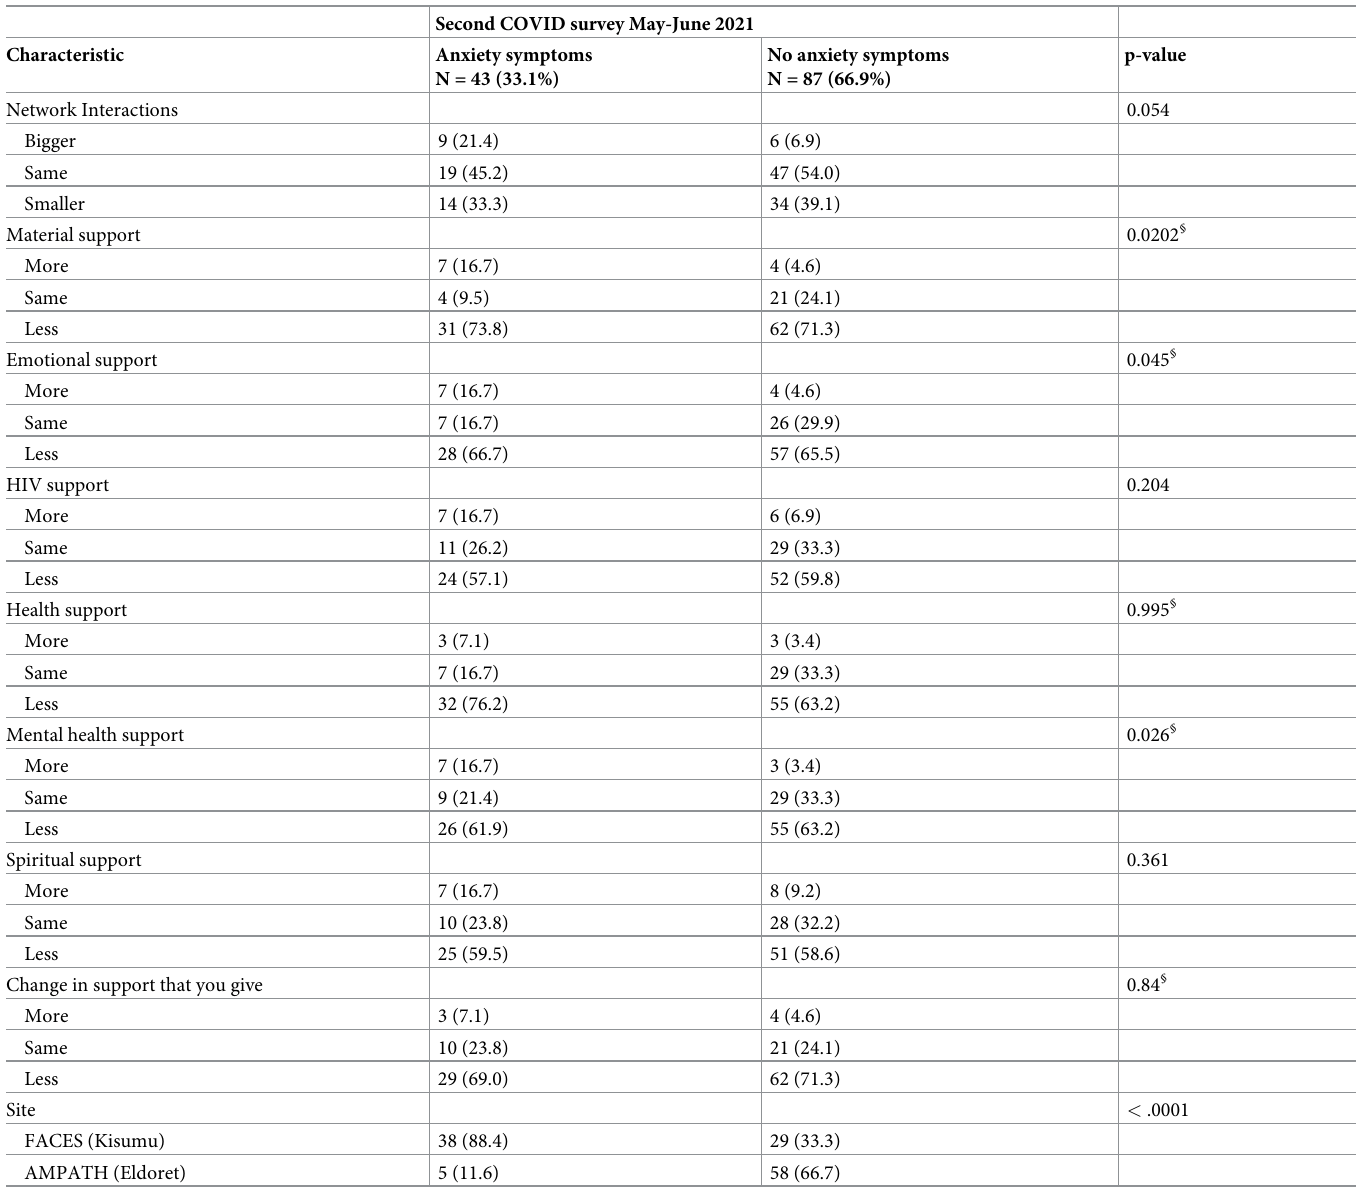
Table 5. COVID-19 survey: Social support and other factors associated with anxiety (GAD-2 � ). Second COVID survey May-June